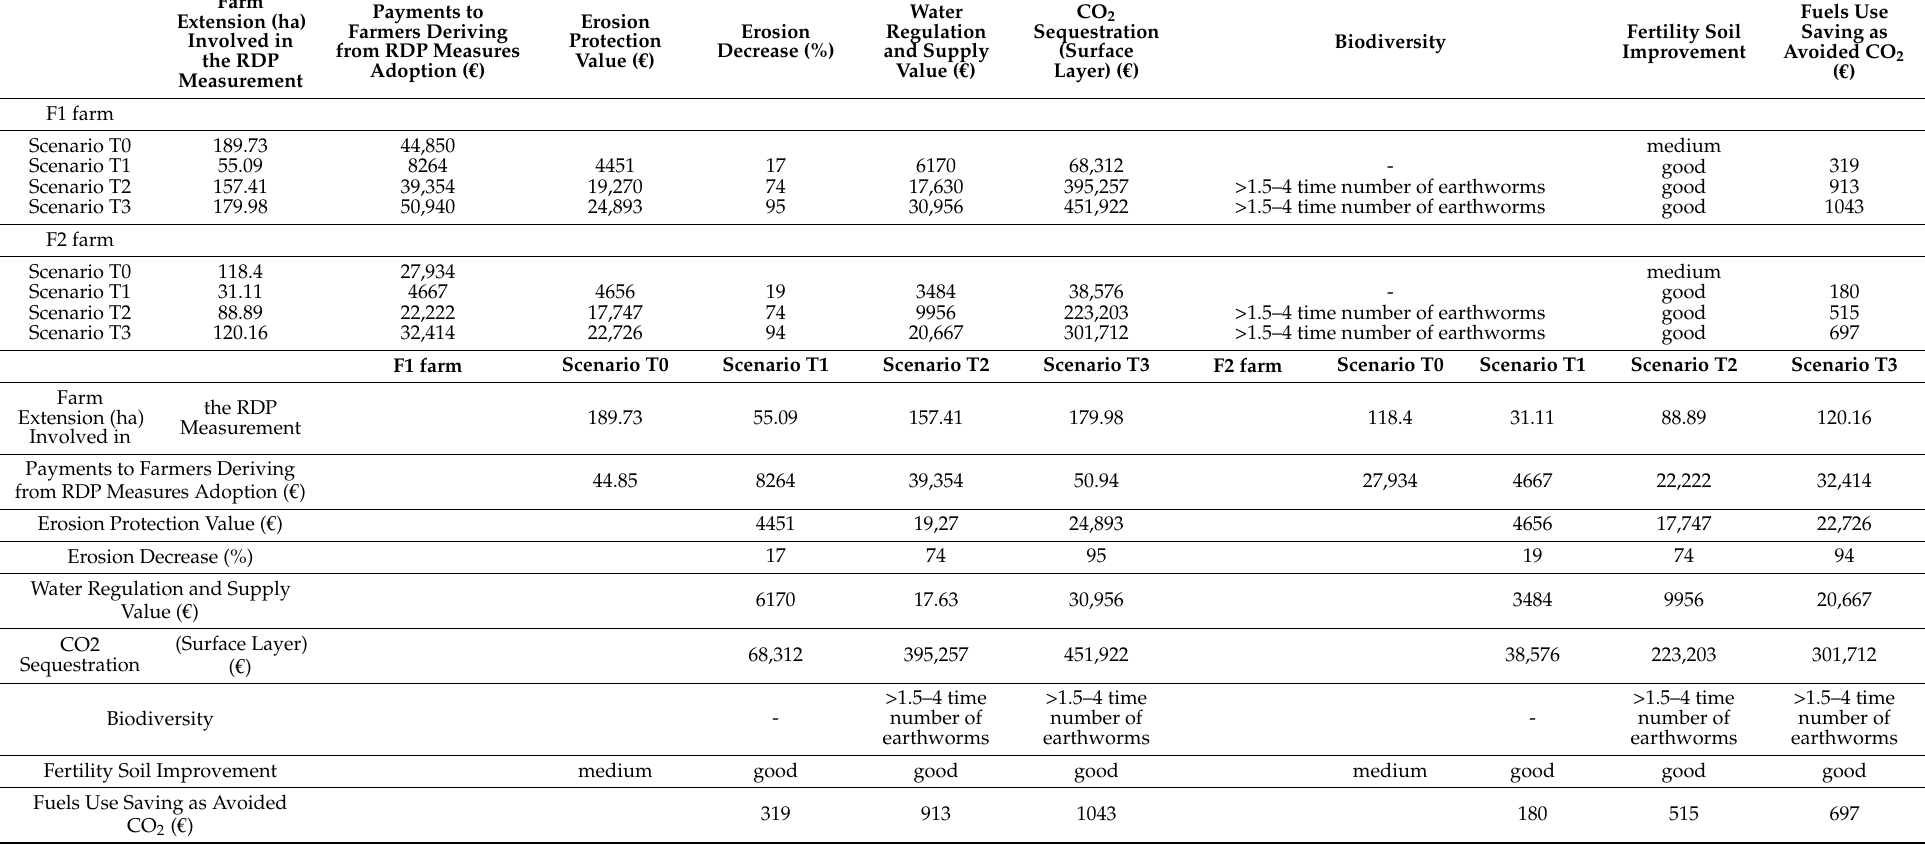
Table 8. Values of ecosystem services provided by different scenarios in two